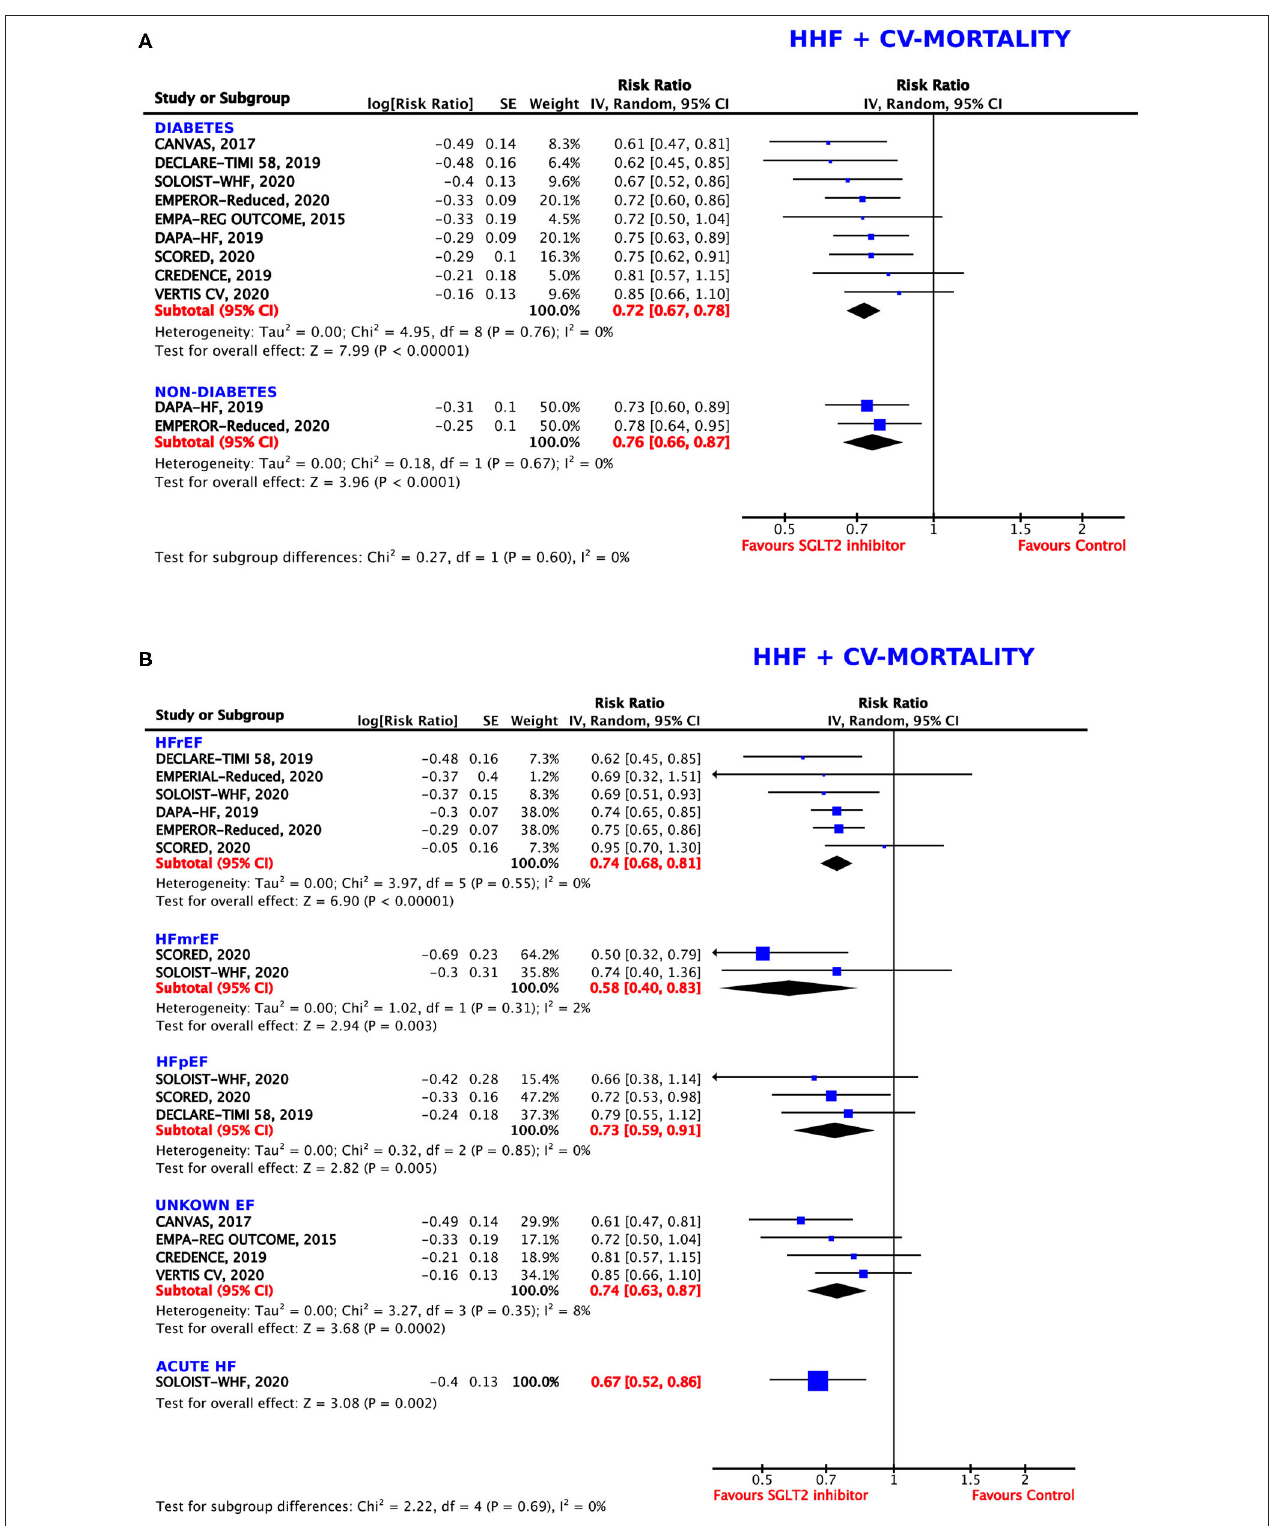
FIGURE 2 | Forest plot depicting the relative risk (RR) for the composite outcome of hospitalization for heart failure (HHF) or cardiovascular (CV) mortality in (A) patients with or without diabetes and (B) depending on the type of heart failure (HF): HFrEF (HF with reduced ejection fraction), HFmrEF (HF with mid-range ejection fraction), HFpEF (HF with preserved ejection fraction), unknown EF, and acute HF.